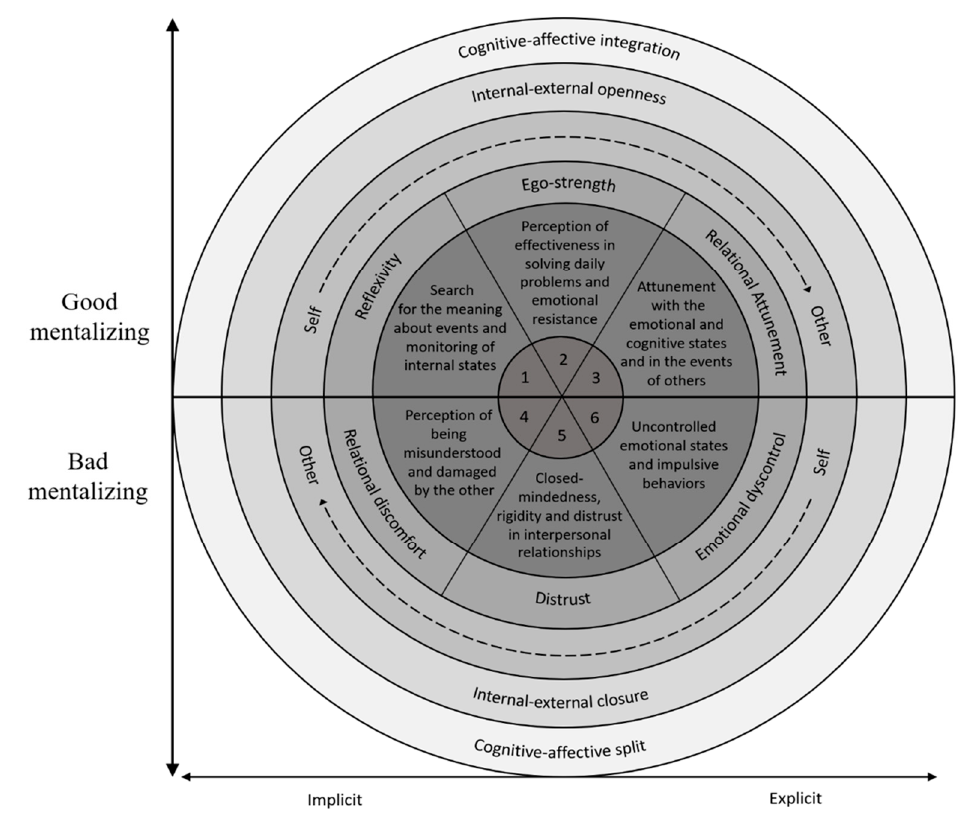
Figure 2. Integrated and multilevel model of mentalizing.